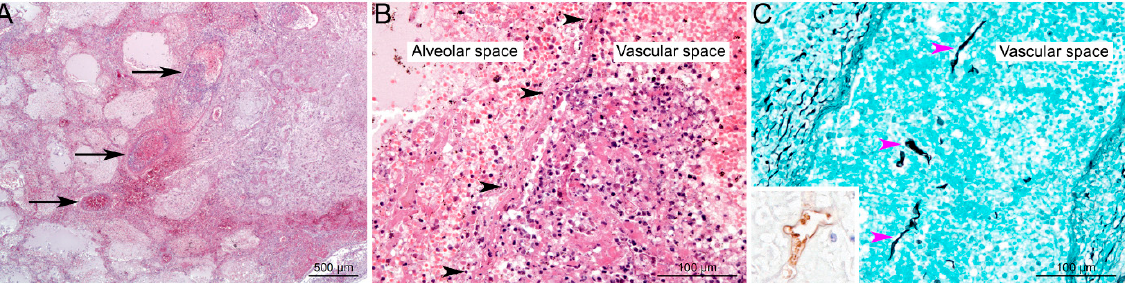
Figure 4. Histological lesions in pulmonary Mucormycosis. ( A ) Focal well ‐ delineated lesion, centred on arteries and veins of medium calibre (black arrows), characterized by vascular alterations associated with peripheral alveolar oedema, acute hemorrhages, ischemic necrosis, and minimal inflammation (pulmonary infarction) (HE staining). ( B ) Higher magnification of vascular lesions: thrombi and destruction of vascular wall (black arrowheads), associated with alveolar hemorrhages, oedema and minimal inflammation (mostly neutrophils) (HE staining). ( C ) Hyaline, pleomorphic hyphae are detected in the lesions; very often invading vascular spaces (pink arrowheads). Hyphae are irregular in size (from 3 to 25 µ m in diameter), folded, rarely septate (pauciseptate), branching (at right angles) with a ribbon-like morphology, and could be highlighted using Grocott’s Methenamine Silver staining, or immunohistochemistry (inset; primary antibody: GeneTex GTX39191; WSSA-RA-1). Used with kind permission from G. Jouvion. Reproduced from New developments in Mucormycosis , Semin Respir Crit Care Med 2015; 36: 692–705 (Publisher Georg Thieme Verlag